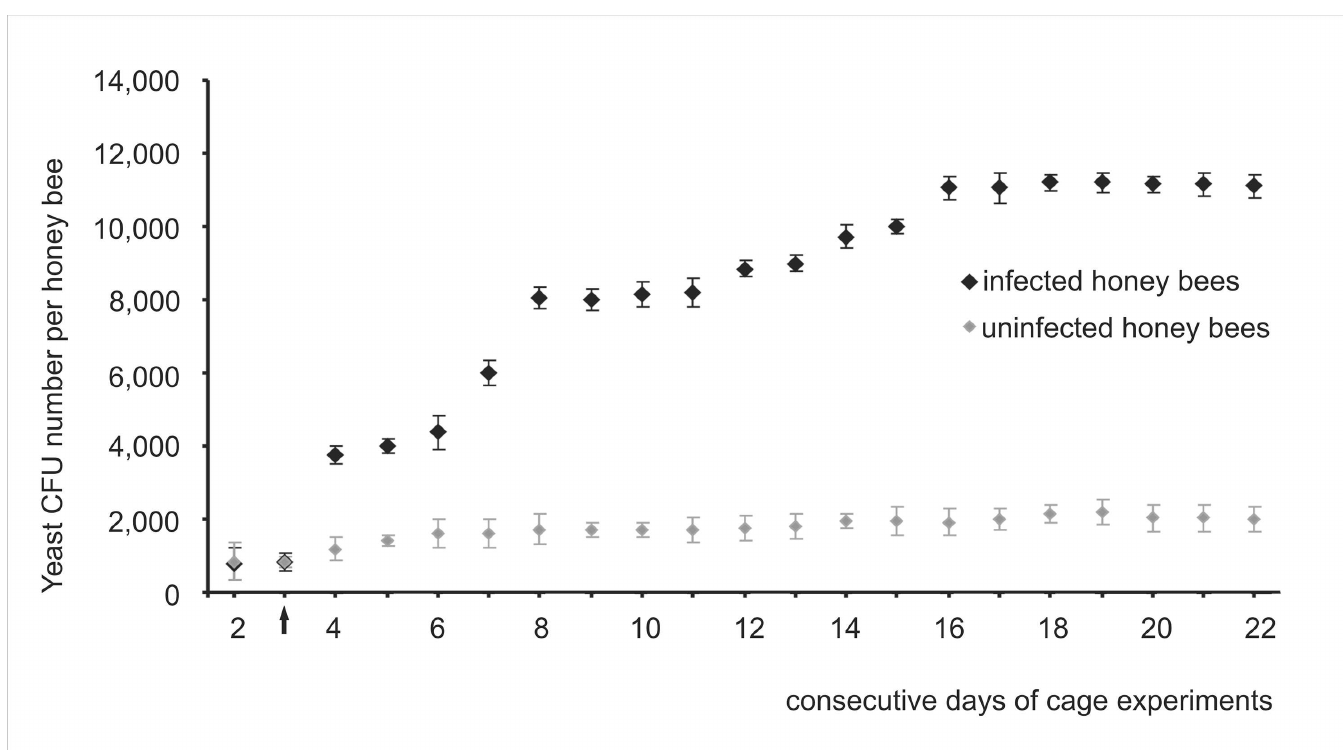
Fig 4. Cage tests. The average yeast CFU number observed during consecutive days of cage experiments conducted in 2014 and 2015. Data obtainedfrom daily samplingfrom the second day of workers emergingto the end of each experimentin 2014 and 2015. The arrow ( " ) indicatesthe day of N . ceranae infection. Diamondshapes ( ♦ ) represent means while error bars indicate standard